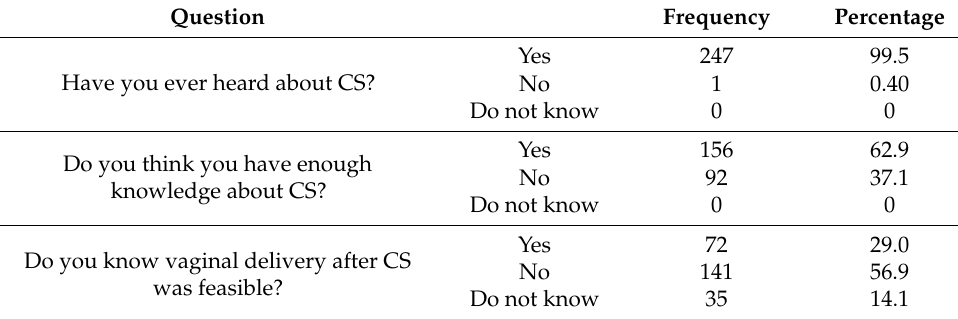
Table 4. Knowledge regarding CS in the study